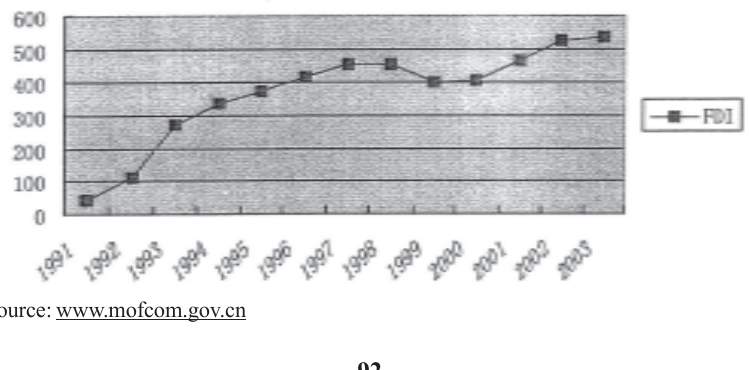
(In 100 million US